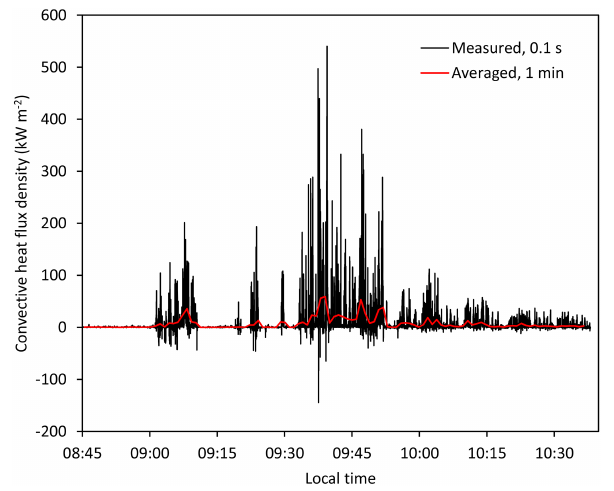
Figure 6. Total particle number concentrations measured on an air- craft in Hyytiälä during the flaming stage on 26 June 2009 (grey and black dots), and the predicted plume centre line trajectory for case 1, assuming k v = 1 and k v = 0 (Eq. 11) (black solid and dashed lines), and cases 2–4, assuming k v = 1 (green, orange and blue lines). The measured particle number concentrations ( c ) have been classified into two separate categories: highest (black dots) and medium-high (grey dots) concentrations (the ranges are indicated in the figure caption). The particle number concentrations were determined for particles with an aerodynamical diameter larger than